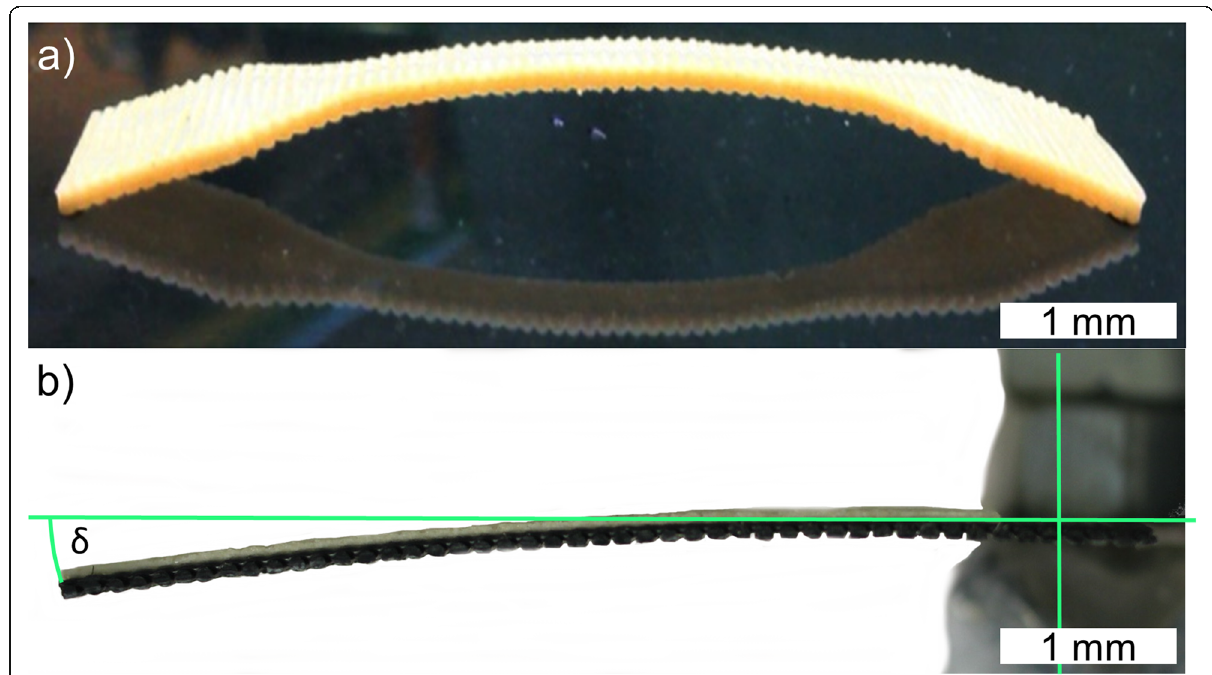
Fig. 2 a Illustration of an axial AC25% hygromorph after water-immersion for 2 min. b Example for the evaluation of the actuation of a 3D- printed after storage in a climate chamber at RH = 75%. The green horizontal line represents the position of the bilayer prior to the change in humidity at RH = 30%